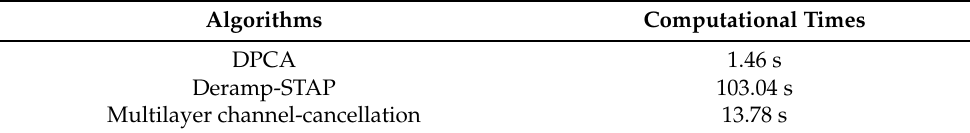
Table 8. Comparison of computational times of various algorithms and the proposed algorithm.